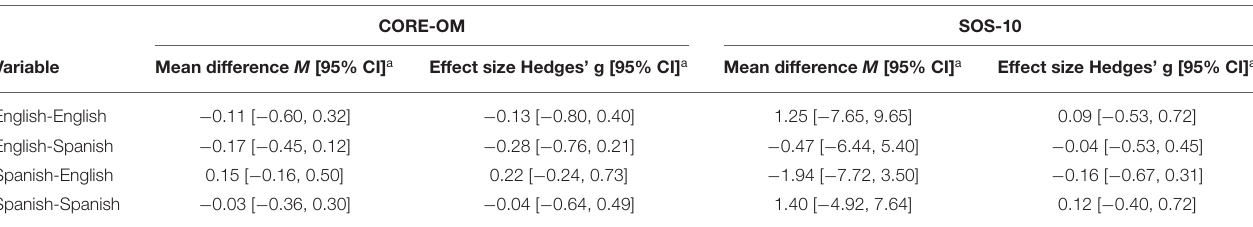
TABLE 1 | Mean differences and effect sizes for the effect of time and language. CORE-OM